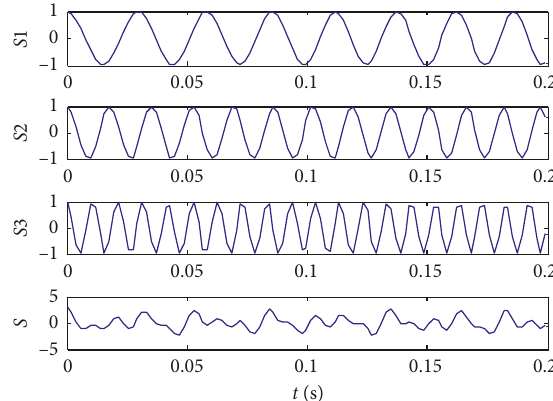
Figure 1: Time-domain waveform of the simulated signal.